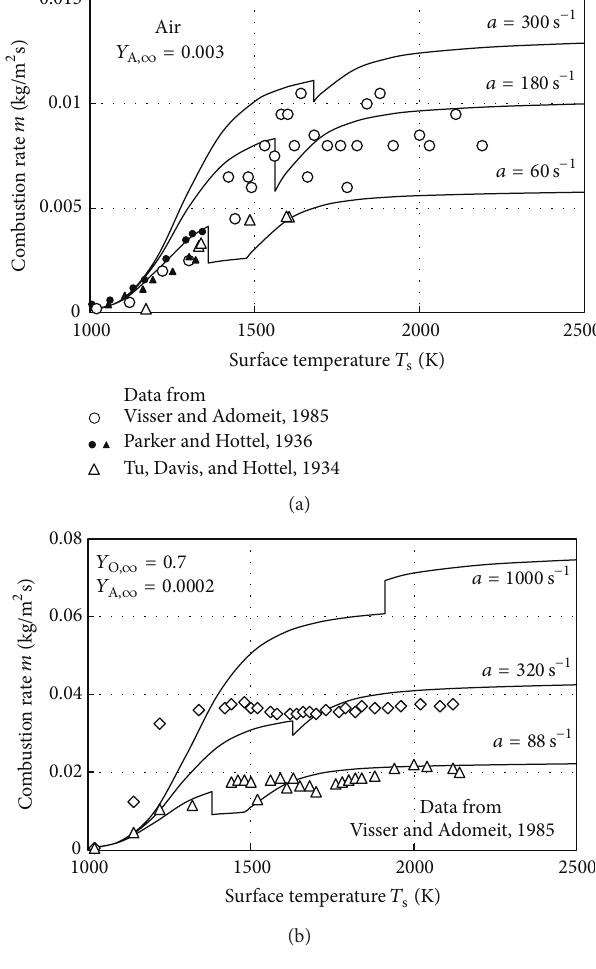
Figure 7: Combustion rate as a function of the surface temperature, with the velocity gradient taken as a parameter: (a) in airflow with = 0.003 ; (b) in oxidizing-flow with the H 2 O mass-fraction 𝑌 A ,∞ = 0.7 and 𝑌 = 0.0002 . Data points are experimental results 𝑌 O ,∞ A ,∞ [34, 59, 63] in airflow and those [34] in oxidizing flow; curves are calculated by use of the explicit combustion-rate